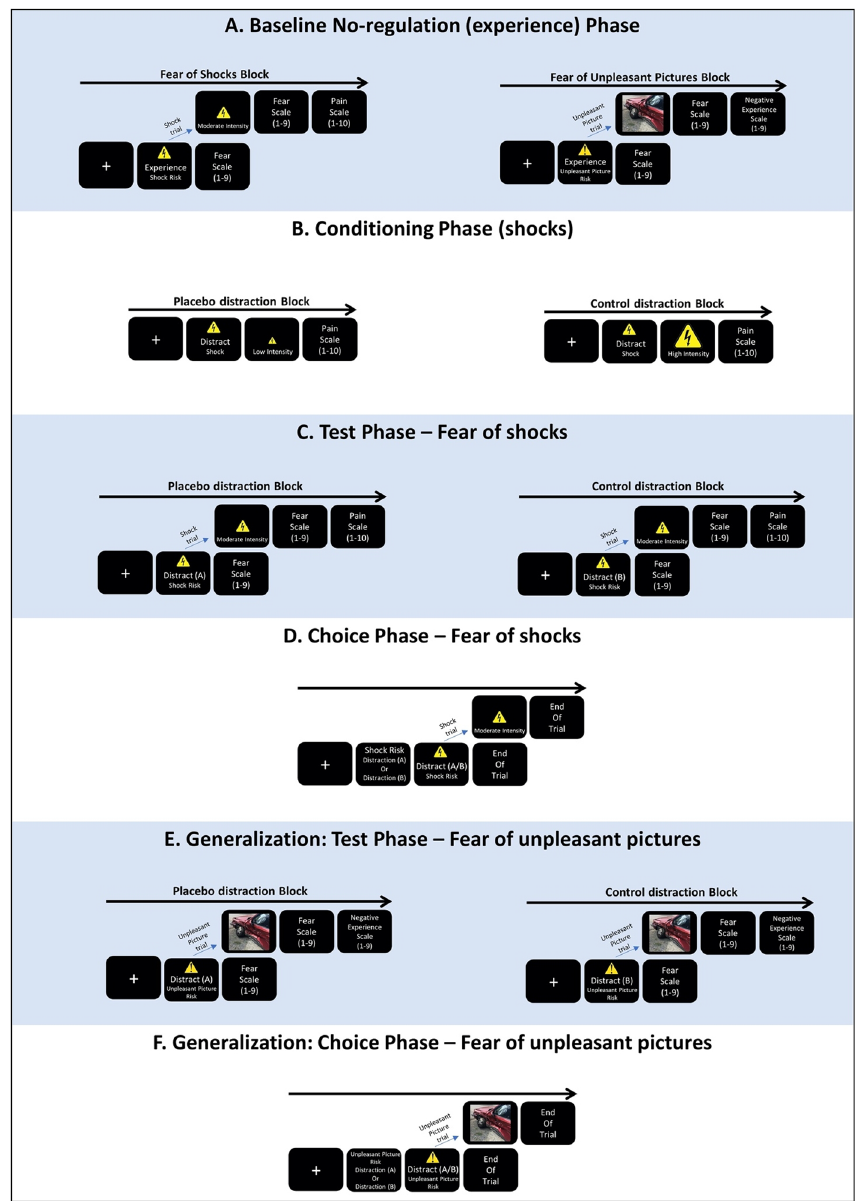
Figure 1. Study overview: schematic trial structures of the different study phases. ( A ) The baseline no-regulation (experience) phase included two blocks—a fear of shocks block and a fear of unpleasant pictures block. Participants were asked to allow natural thoughts and feelings to arise while anticipating a possible shock/ unpleasant picture. In trials with an electric shock/an unpleasant picture, they were asked to continue allowing their feelings to naturally arise. ( B ) The conditioning phase included two counterbalanced blocks—one for the placebo-distraction, which was presented as effective and paired with low intensity shocks, and one for the control-distraction, which was presented as not effective and paired with high intensity shocks. ( C ) The test phase included two counterbalanced blocks—one for the placebo-distraction and one for the control- distraction. These blocks were identical to the fear of shocks block in phase A, except that here participants implemented the two distractions instead of the experience instruction. ( D ) This phase included one block where participants freely chose between the two distractions while anticipating a possible shock. ( E ) The generalization test phase included two counterbalanced blocks—one for the placebo-distraction and one for the control-distraction. These blocks were identical to the fear of unpleasant pictures block in phase A, except that here participants implemented the two distractions instead of the experience instruction. ( F ) The generalization choice phase was identical to phase D, except that here participants freely chose between the two distractions while anticipating a possible unpleasant picture. In compliance with copyright laws, the picture used for this illustration is similar to, but not taken from the set of pictures presented in the